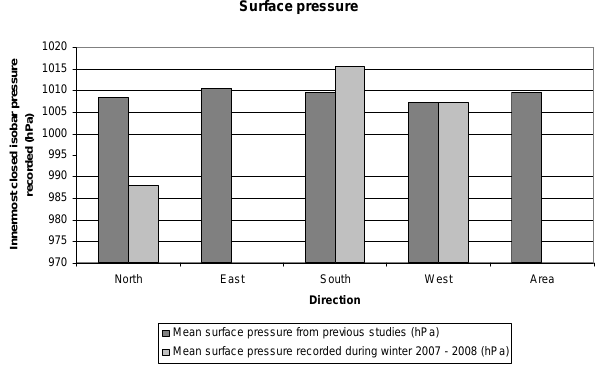
Fig. 3. Comparison between the mean minimum sea level pressure of the clusters in the study period against previous studies.